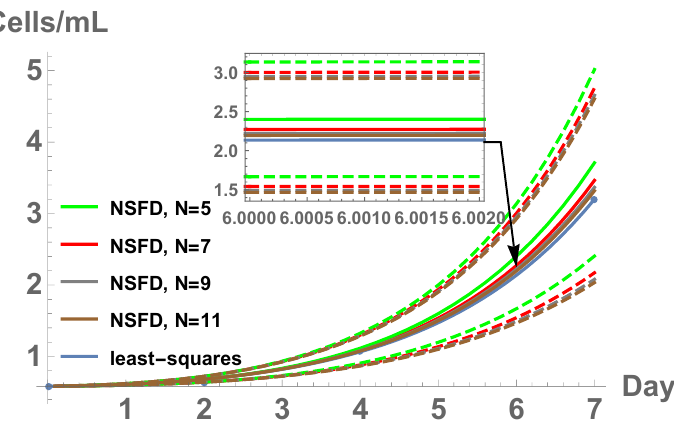
Figure 8. Application of the random NSFD scheme for the model of the R. capsulatus bacterial population, for M = 2 and different values of N (mean values in solid line, and mean ± 2 × standard deviation in dashed lines). The least-squares fitting is also plotted. A zoom for a particular region is included for a better appreciation of convergence as N grows. This figure corresponds to Example